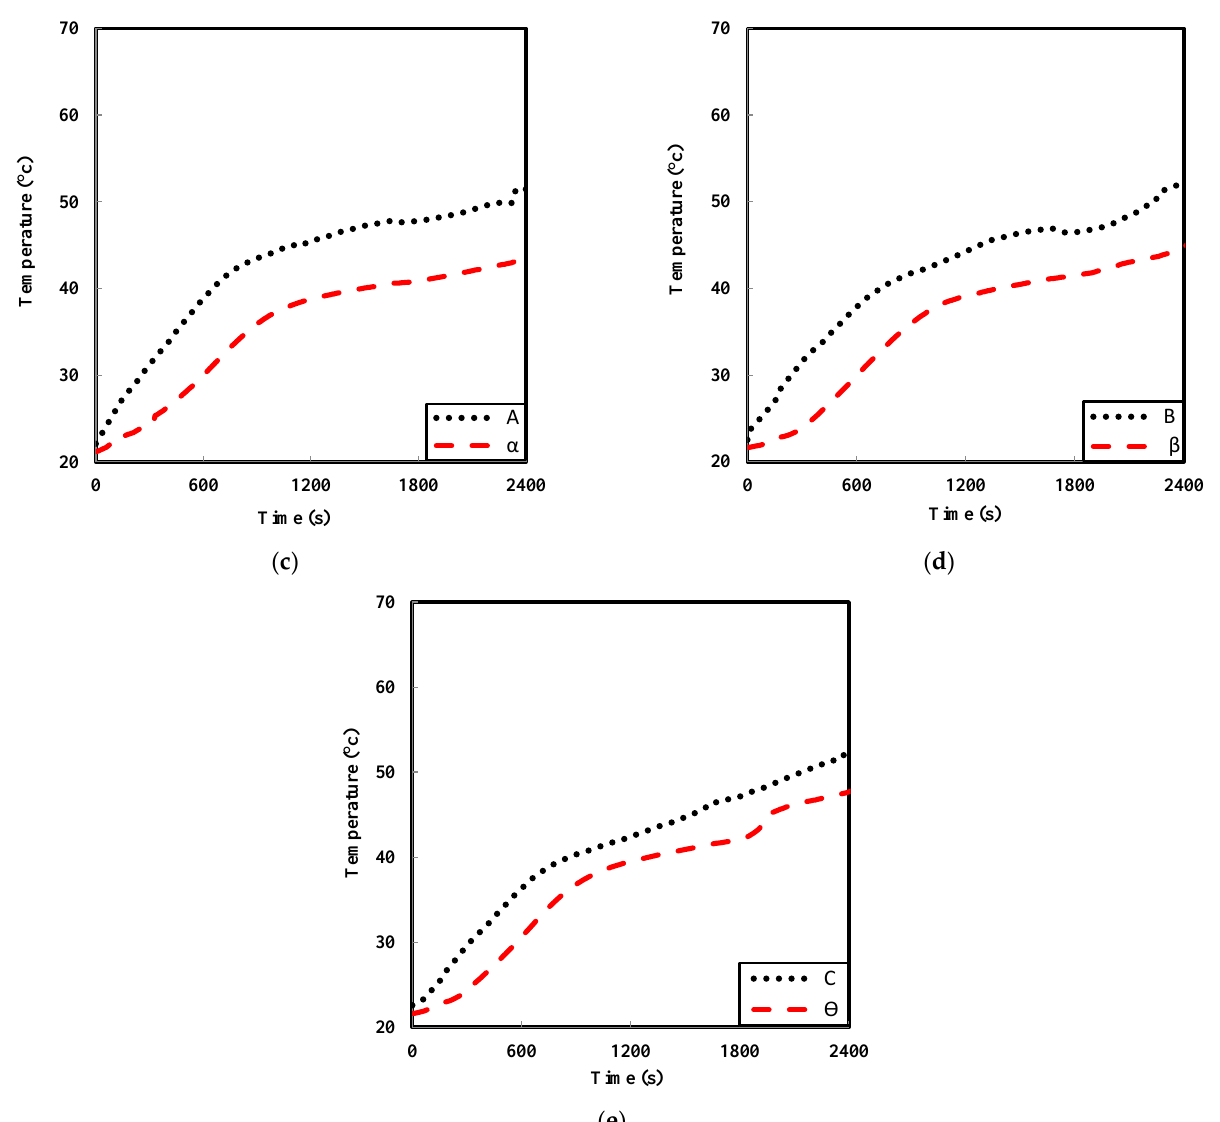
Figure 5. Scheme of experimental charging temperature evolution plots as a function of the axial position versus time (70 ◦ C), ( a ) thermocouples in the radius of 6 mm, ( b ) thermocouples in the radius of 13 mm, ( c – e ) temperature comparison of the thermocouples in 6 mm and 13